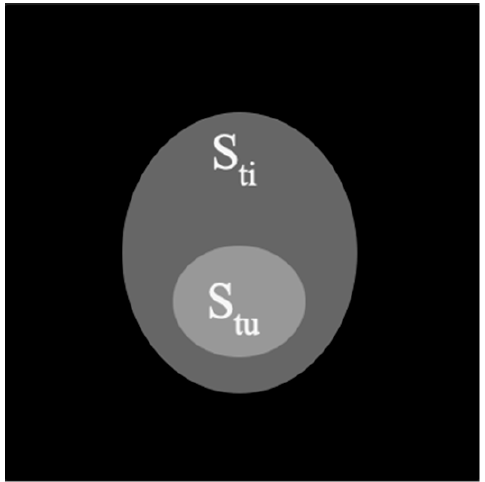
Figure 1. An image of a phantom tumor model comprising tumor (tu) surrounded by a normal adjacent tissue (ti) used for contrast analysis.